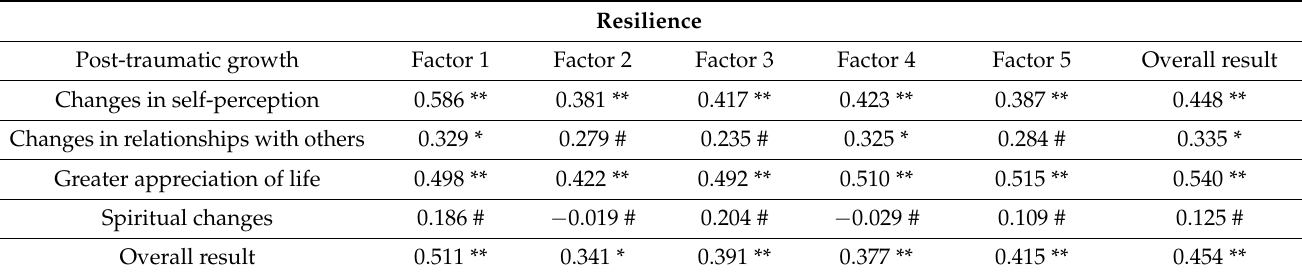
Table 3. Values of the correlation coefficient of resilience with post-traumatic growth in the recipient from the cadaveric donor.